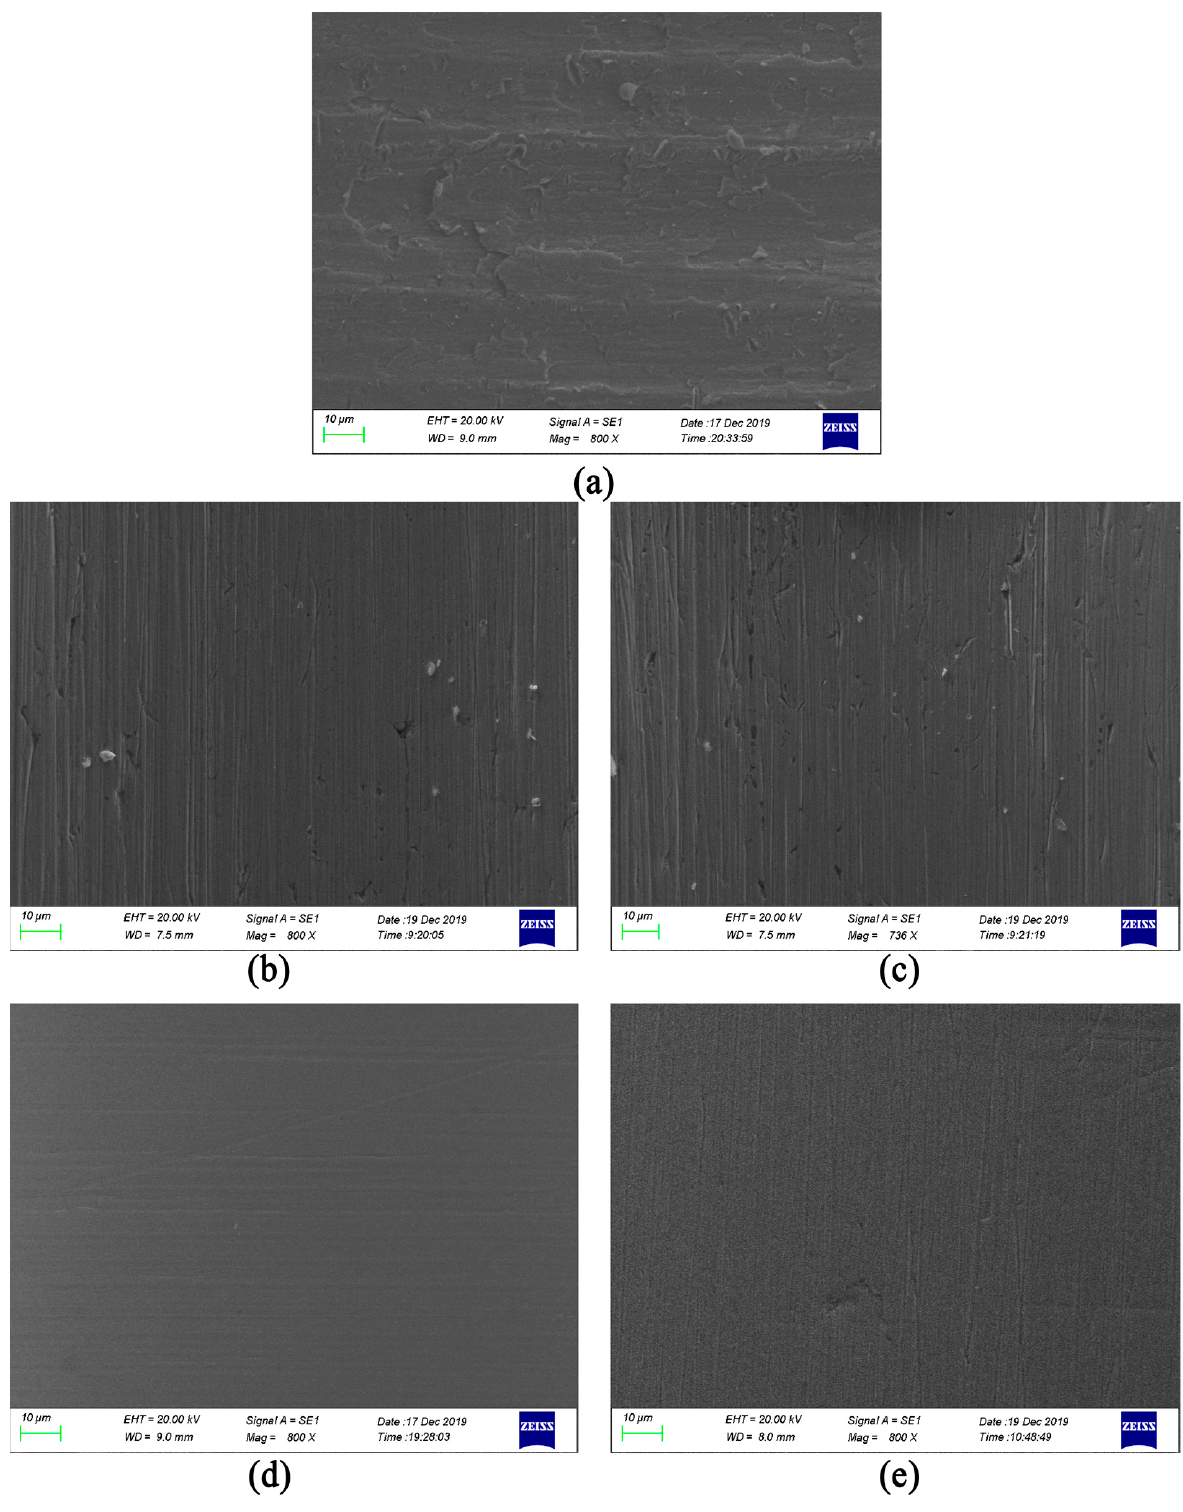
Figure 5. Scanning electron microscope image of the workpieces. ( a ) Original #0; ( b ) Sample #1; ( c ) Sample #2; ( d ) Sample #3; ( e ) Sample #4.